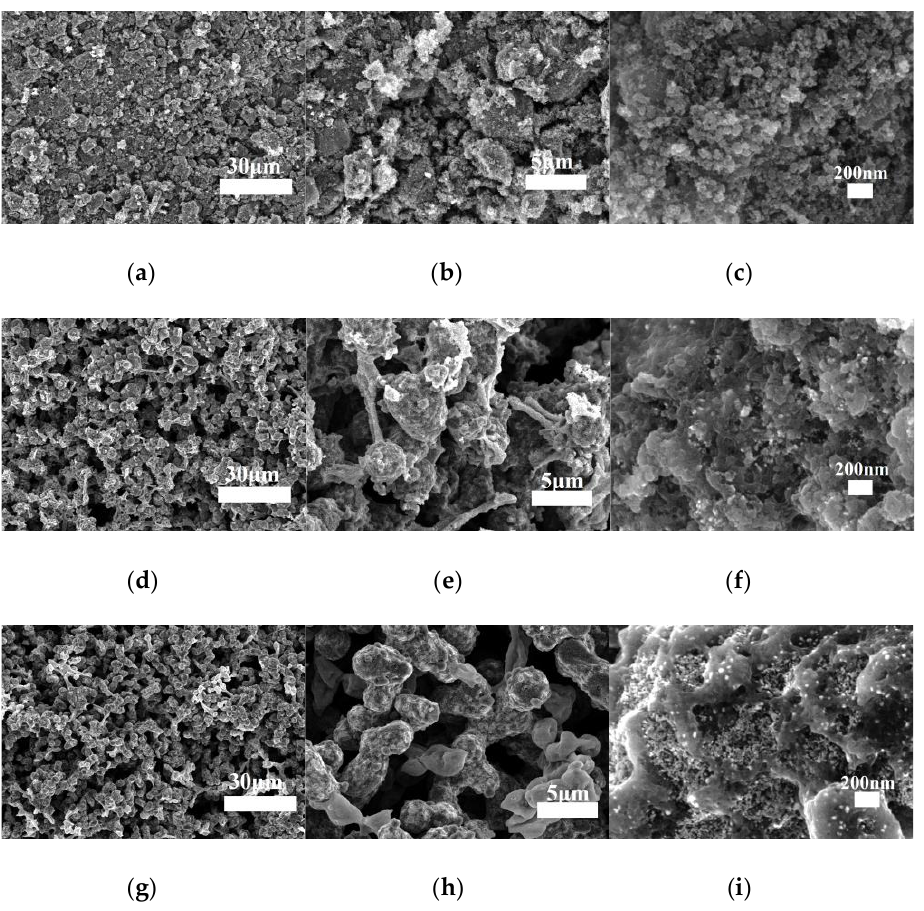
Figure 7. SEM images of the ceramic monoliths after pyrolysis in vacuum at 1400